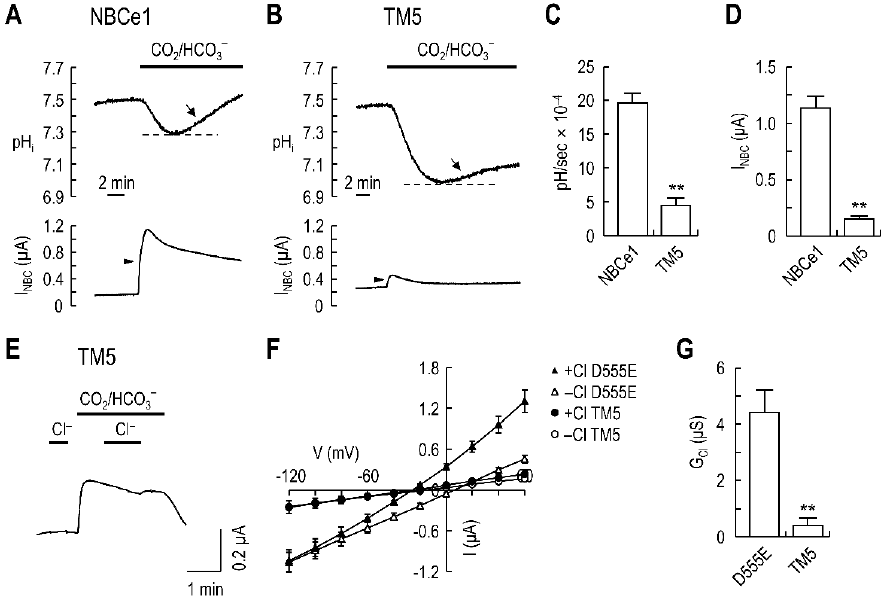
Figure 3. The TM5-replaced chimeric transporter does not induce I Cl . ( A ) Representative pH i and I NBC produced by NBCe1. pH i and I NBC were simultaneously recorded in voltage clamp. pH i recovery ( arrow ) from a CO 2 -induced acidification and I NBC ( arrowhead ) upon CO 2 /HCO 3 − application are hallmarks for electrogenic Na/HCO 3 transport. ( B ) Representative pH i and I NBC , produced by the TM5 chimeric transporter. pH i recovery and I NBC characteristic for electrogenic transport are shown. ( C ) Mean pH i recovery rate, dpH/dt (pH change per sec). The rate was determined by drawing a line during the first 4 min of recovery from acidification ( n = 5/group). ( D ) Mean I NBC . ( E ) Representative I Cl and I NBC mediated by the chimeric transporter. I Cl is absent while I NBC is produced. One of nine recordings is shown. ( F ) I–V relationships of the TM5 chimeric transporter and D555E. Currents were obtained in Cl − -free ND96 ( open markers ) and 1 min after switching to a solution containing 71 mM Cl − ( closed markers ). Data were averaged from 5 oocytes per group. ( G ) Mean Cl − conductance, G Cl . G Cl was calculated from slopes in I Cl –V curve, which is the difference in I – V relationships between the presence and absence of Cl − in ( F ). Slopes were measured near zero-current potentials; ** p < 0.01.